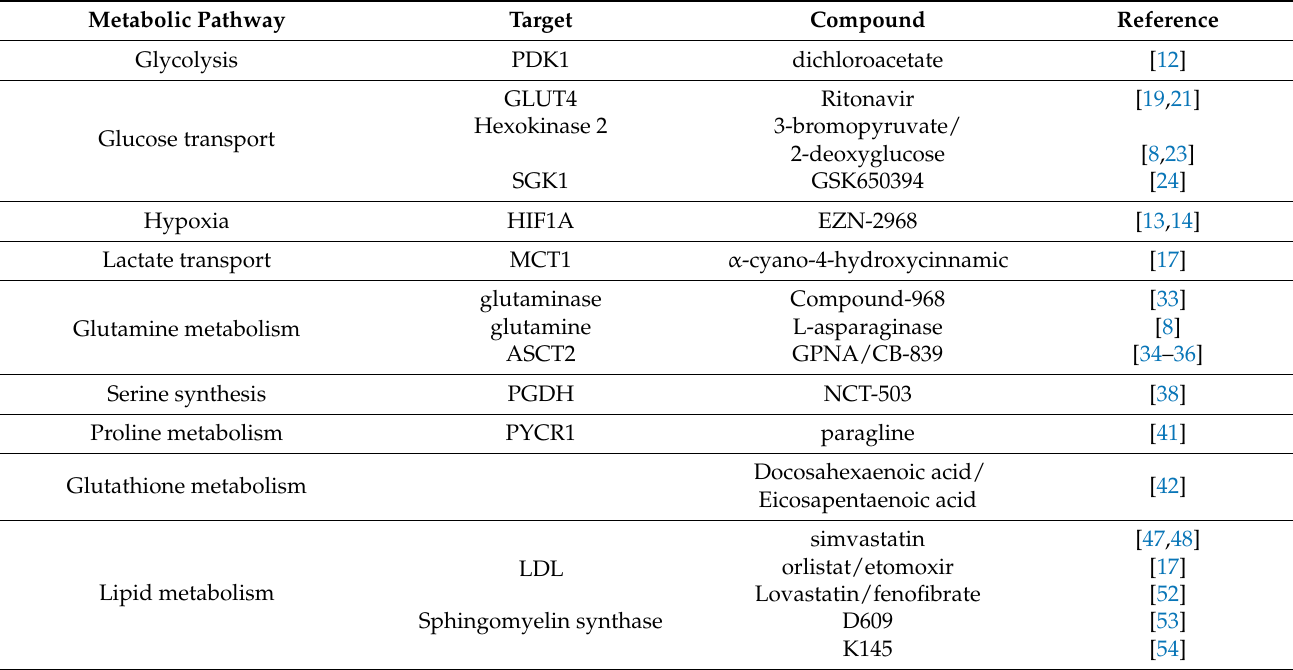
Table 1. Inhibitors of MM cell